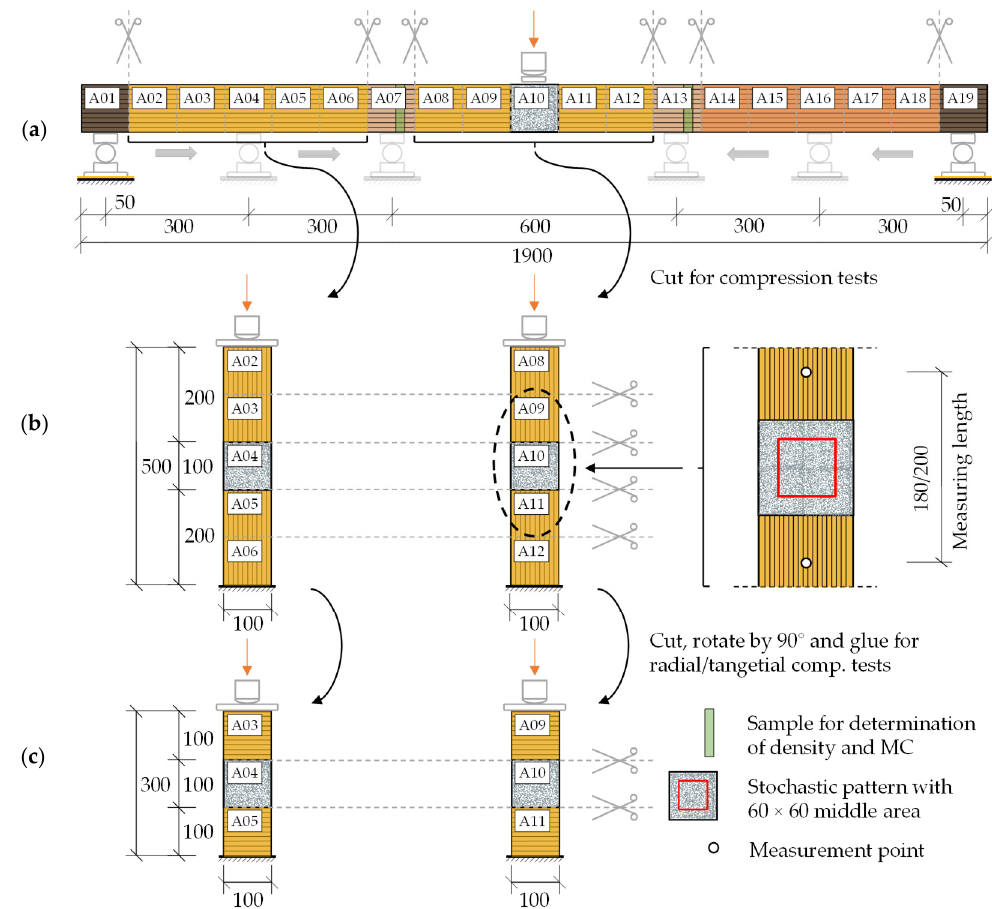
Figure 4. Test setup and partitioning of timber test specimens: ( a ) bending tests flatwise/radial and edgewise/tangential; ( b ) compression test longitudinal; ( c ) compression tests flatwise/radial and edgewise/tangential.